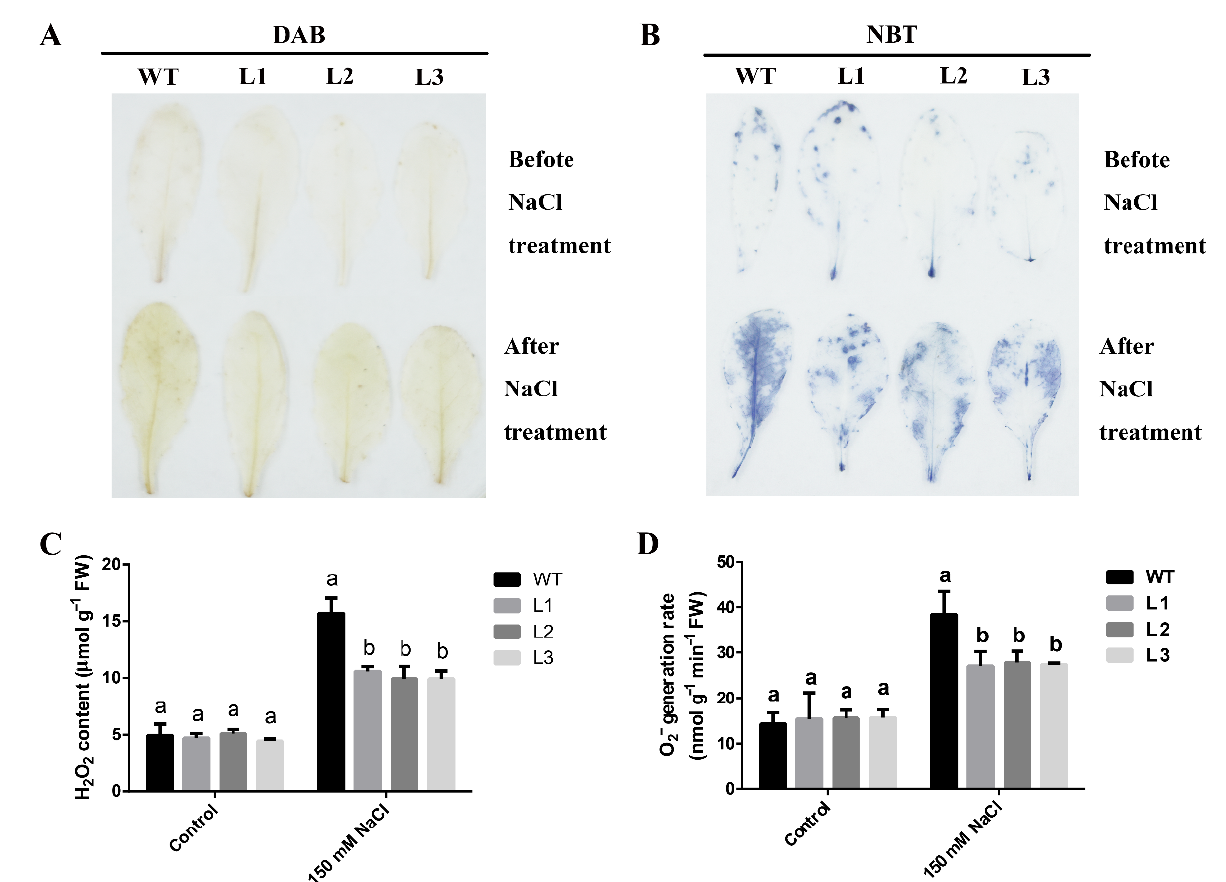
Figure 6. Overexpression of MdLOX3 decreases ROS production under salt treatment for 21 days. DAB staining for H 2 O 2 ( A ) and NBT staining for O 2− ( B ) in WT and MdLOX3 transgenic lines before and after NaCl treatments. The content of H 2 O 2 ( C ) and production rate of O 2− ( D ) in WT and MdLOX3 transgenic lines before and after NaCl treatments. Error bars, ±SD of three independent replicates. Different lowercase letters represent significant differences ( p < 0.05).